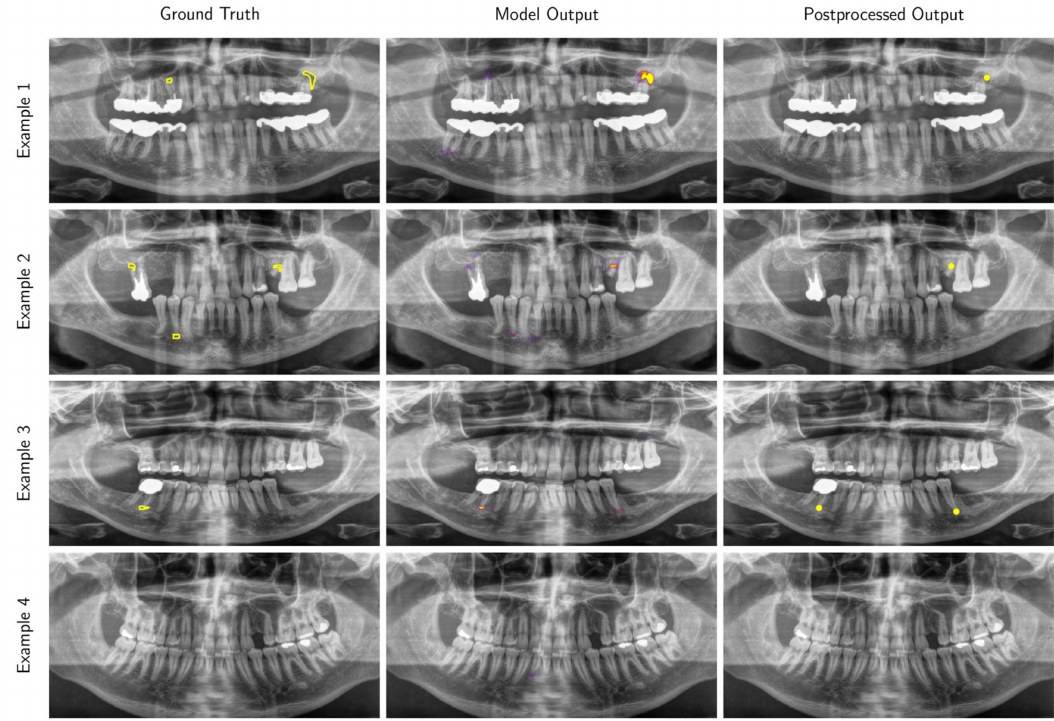
Figure 2. Examples of panoramic radiographic images (preprocessed for model input) selected from the test data set with overlays of the ground truth contours (Ground Truth), the intensity map output produced by our model (Model Output) and locations produced by our post-processing procedure (Postprocessed Output). Only predictions with a confidence score greater than 0.25 are displayed (this threshold was selected to maximize the F 1 score on the validation data set). Higher resolution versions of these images are provided in Figures